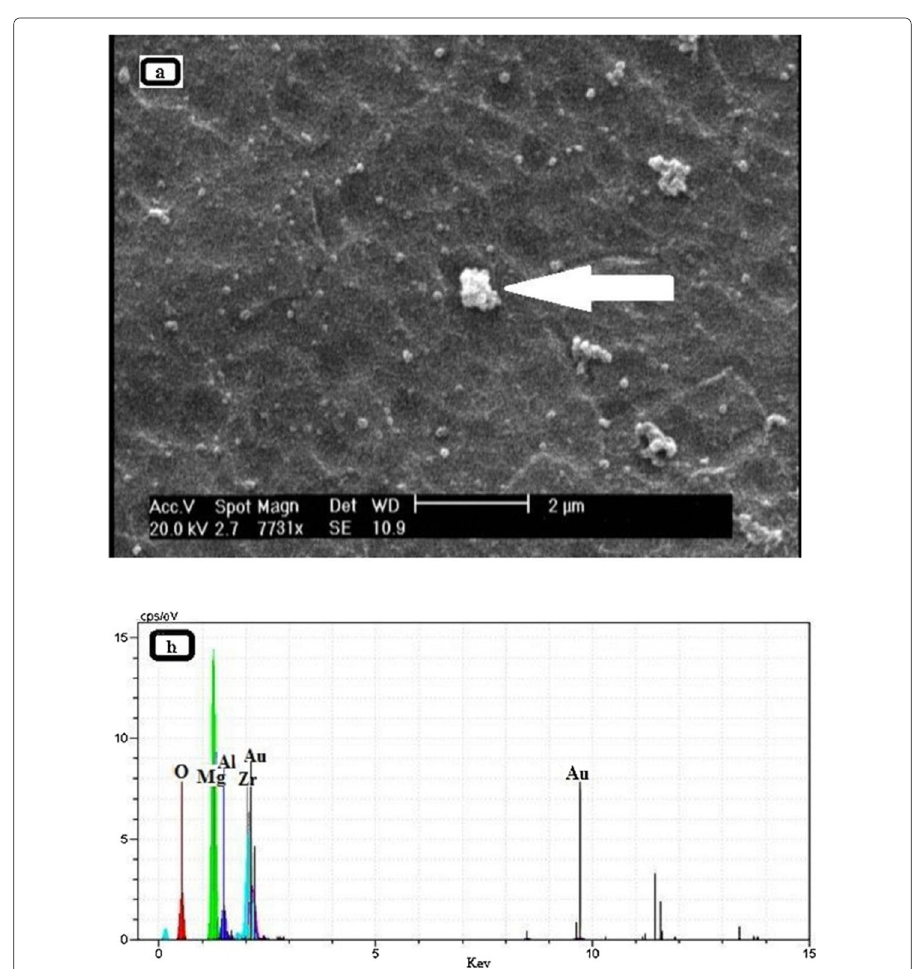
Fig. 7 SEM and EDS images showing dispersion and phases of ZrO 2 in Mg-matrix [102]